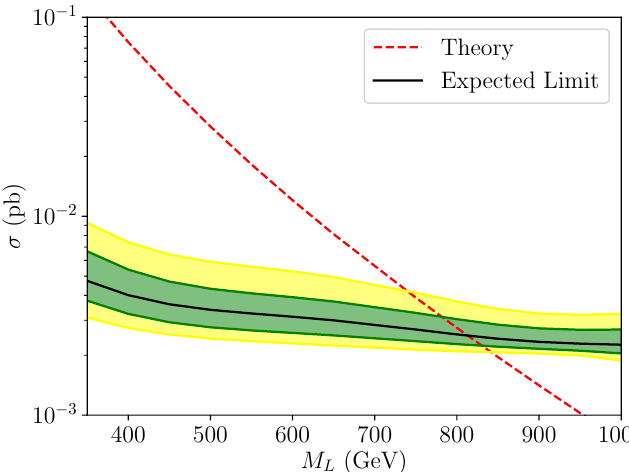
Figure 4 . Exclusion plot for a VLL doublet decaying into electrons (or electron neutrinos) at the